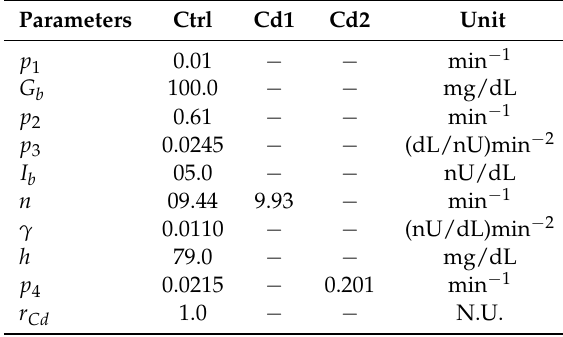
Table 9. Parameters values fitted for the control group as well as groups Cd1 and Cd2 at PND26 (considering Hypothesis 3.2 for Cd2 and Hypothesis 2 for Cd1). Parameters